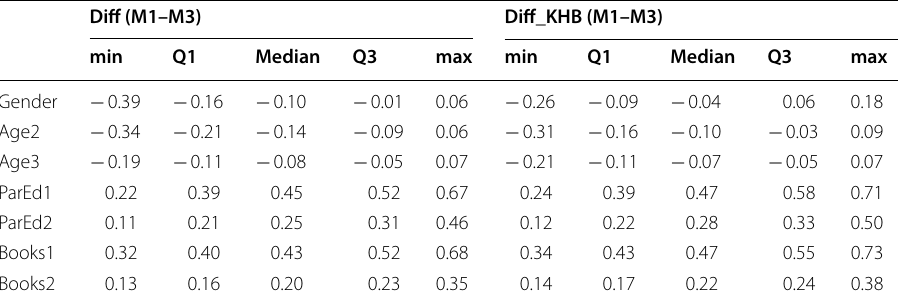
Table 2 5-number summaries for conventional differences and KHB differences, by variable [Q1]